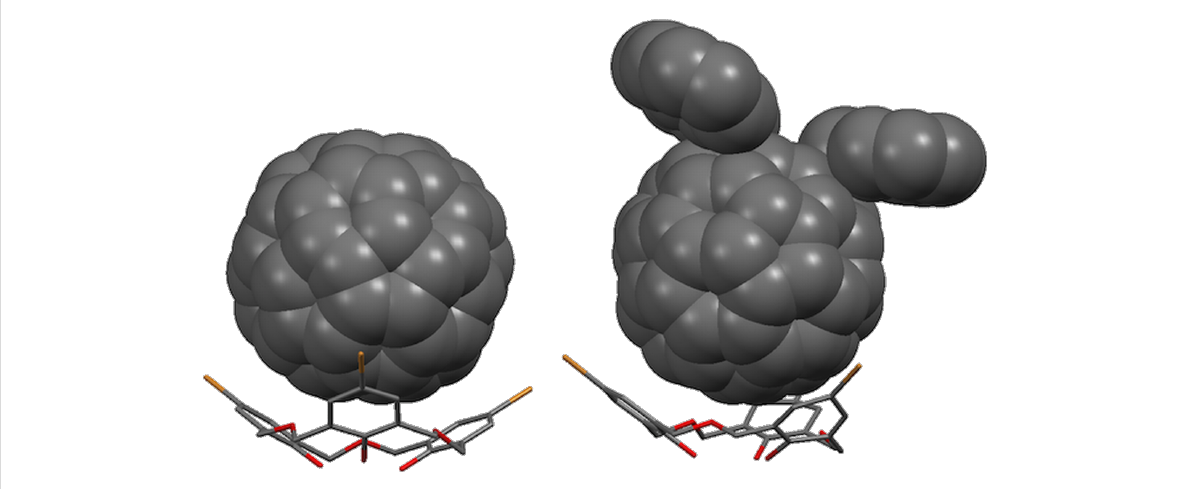
Figure 24: X-ray crystal structures of 3f with C 60 (CCDC ID 182801, left) [76] and a 1,4-bis(9-fluorenyl) C 60 derivative (CCDC ID 139793, right) [78].